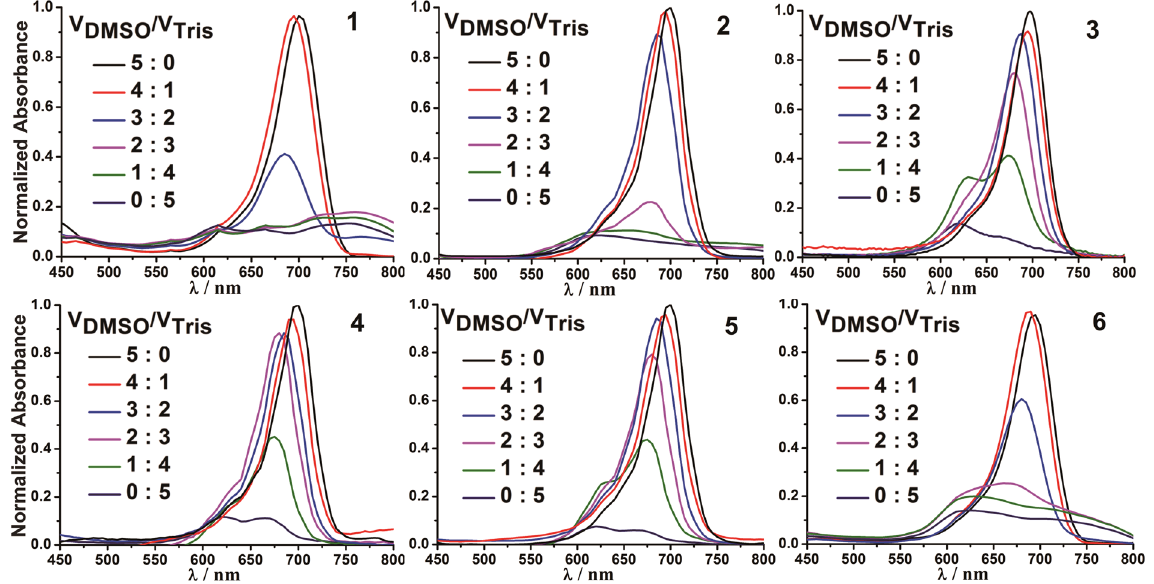
Figure 2. Absorption spectra of 4 μ M compounds in mixed solvents of DMSO and Tris-HCl buffer.